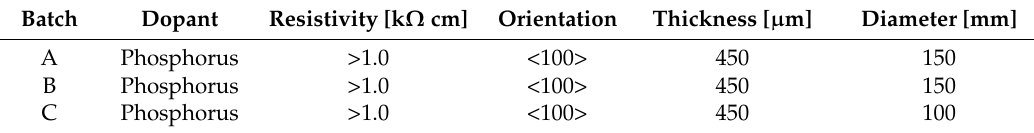
Table 1. Detailed information about the investigated